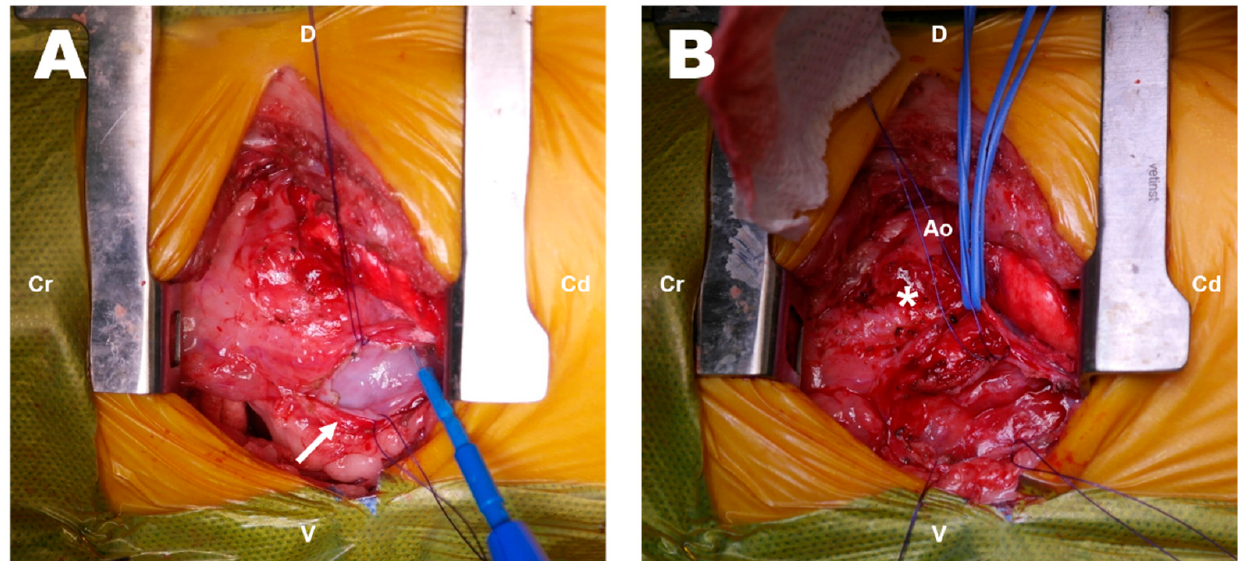
Figure 2. Intraoperative findings on exploratory thoracotomy ( A , B ). Thickened pericardium (arrow) and a lesion (asterisk) that was difficult to distinguish from the surrounding structures. Cr: cranial; Cd: caudal; D: dorsal; V: ventral; Ao: aorta.